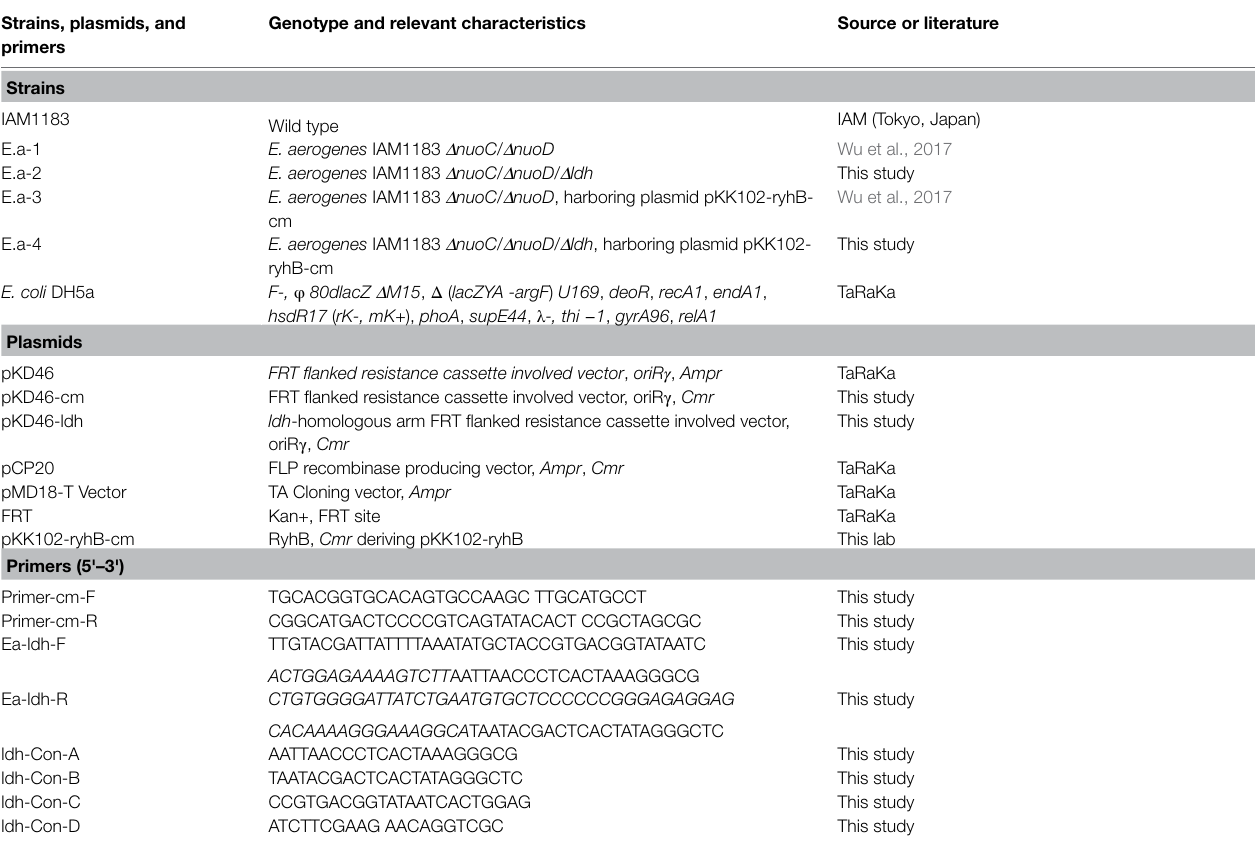
TABLE 1 | Strains, plasmids, and primers used in the experiments. Strains, plasmids, and